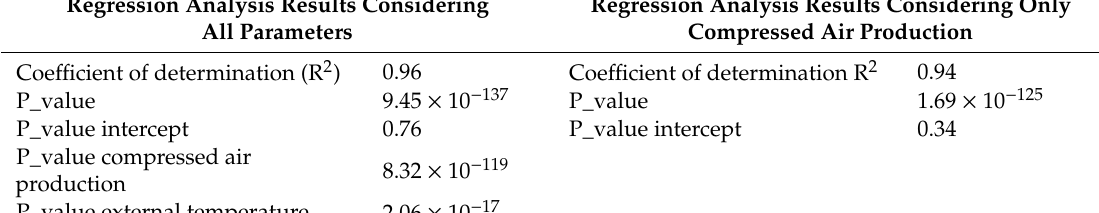
Table 2. Results of the regression analysis.